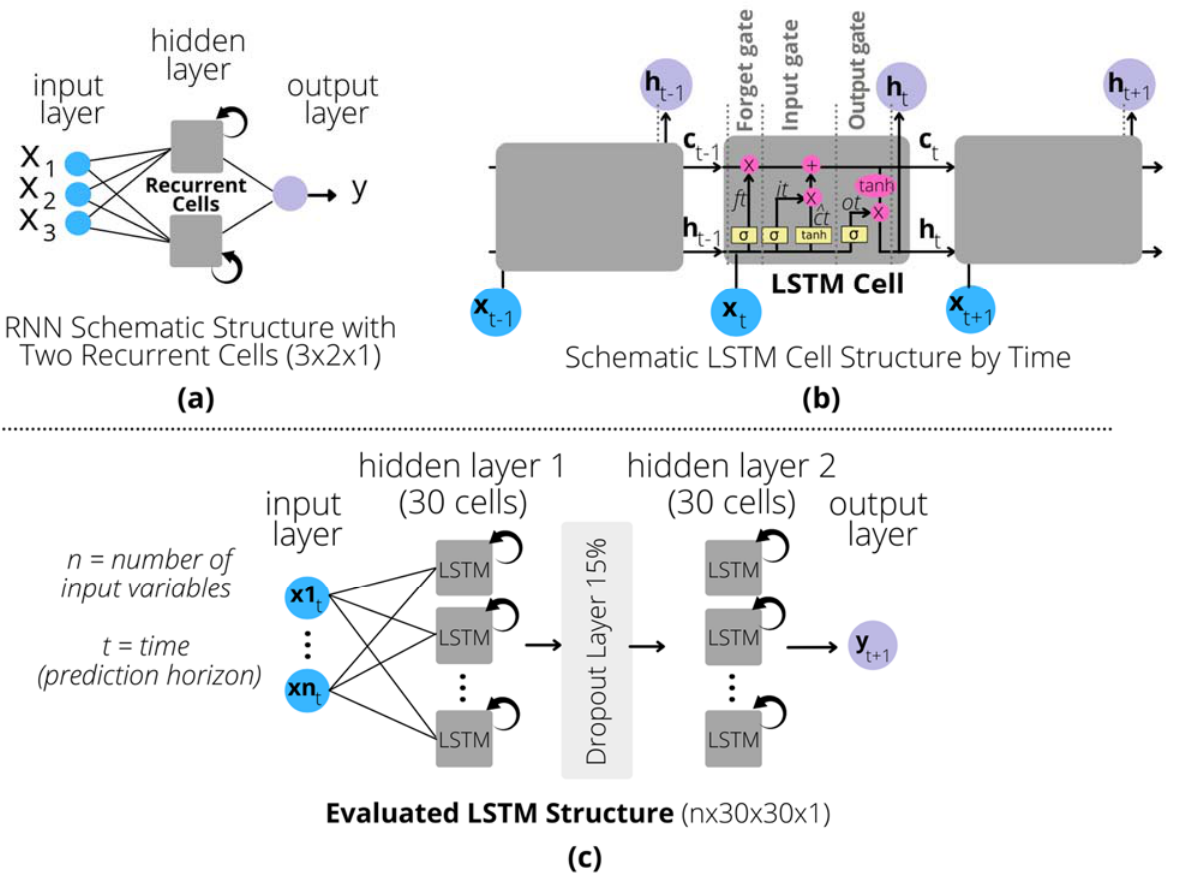
Figure 2. LSTM model: ( a ) an RNN with two recurrent cells, ( b ) an LSTM cell structure with forget gate and ( c ) the LSTM structure adopted in this study (for clarity, the temporal recurrent and enrolled structure is not